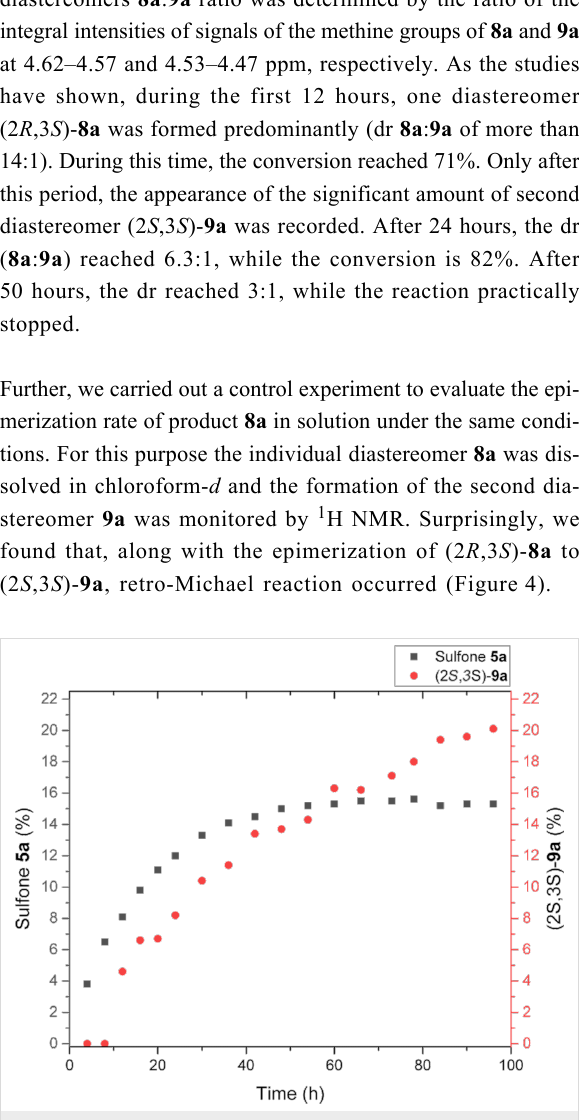
Figure 4: Time profile of epimerization and retro-Michael reaction of (2 R ,3 S )- 8a in chloroform- d solution.